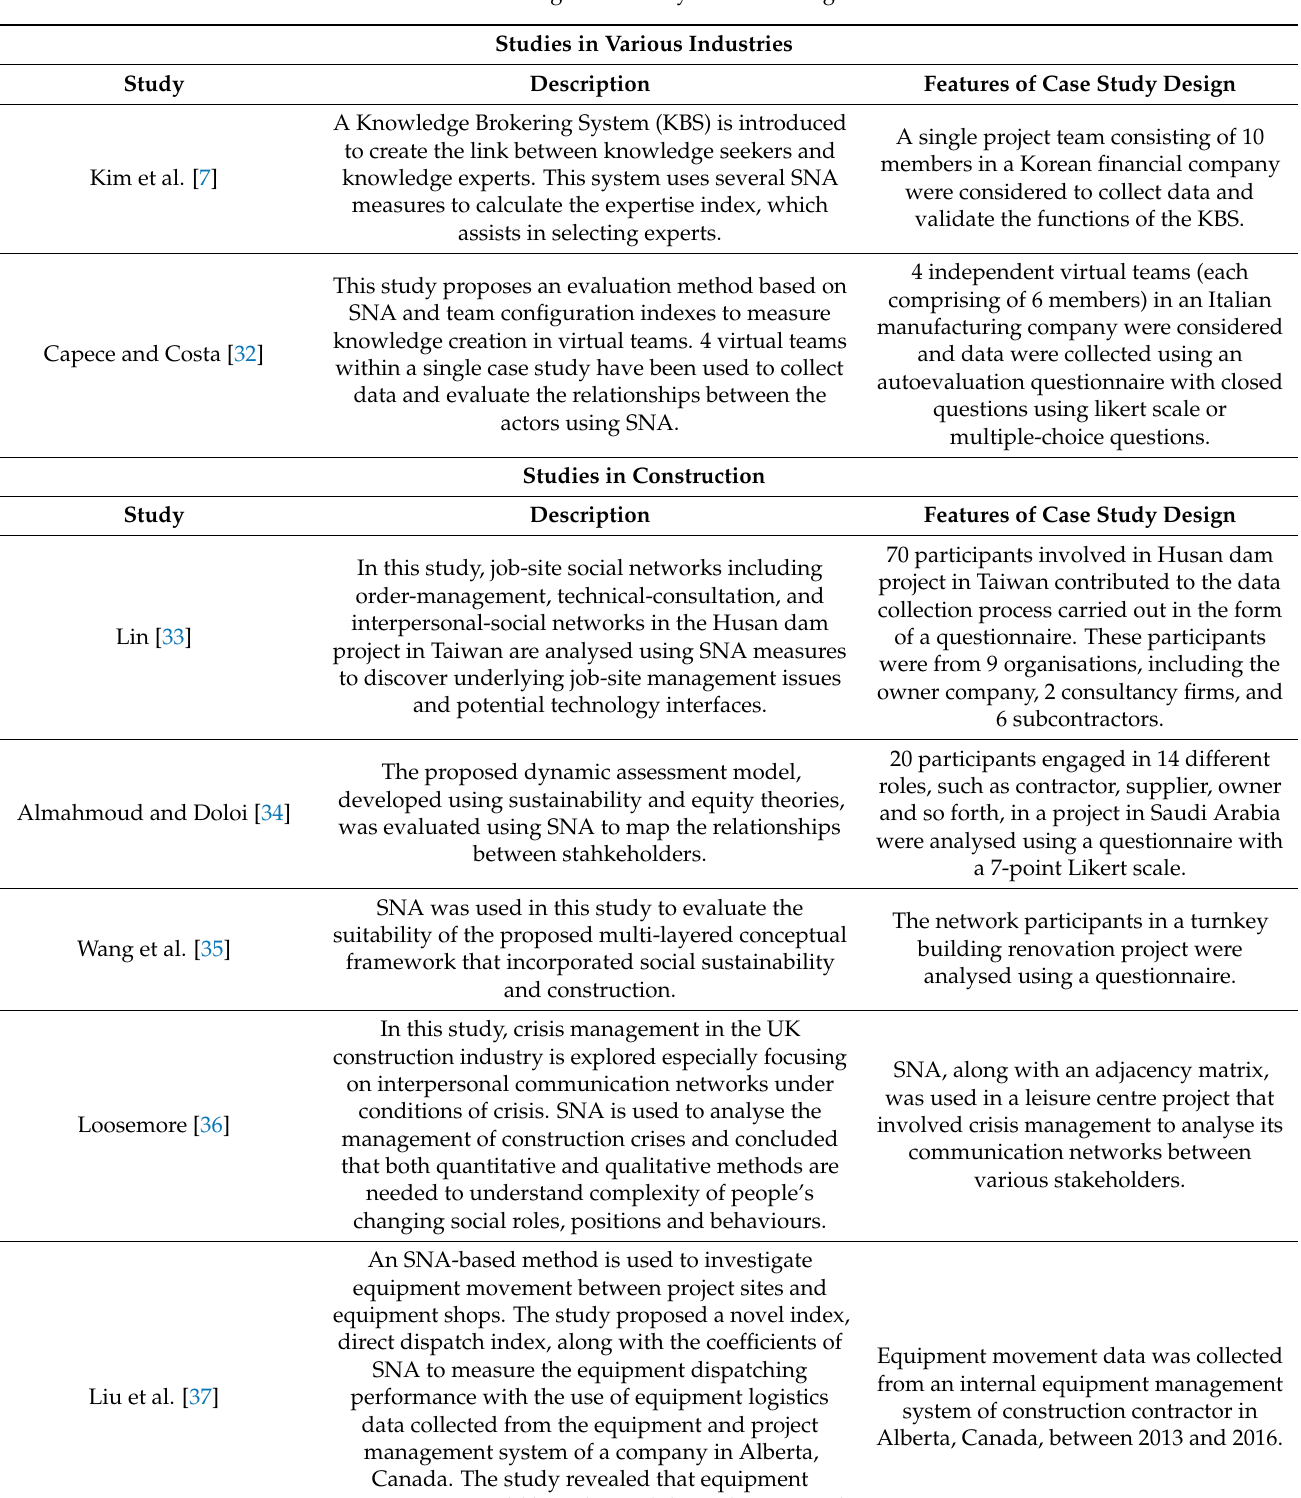
Table 1. Single case study research